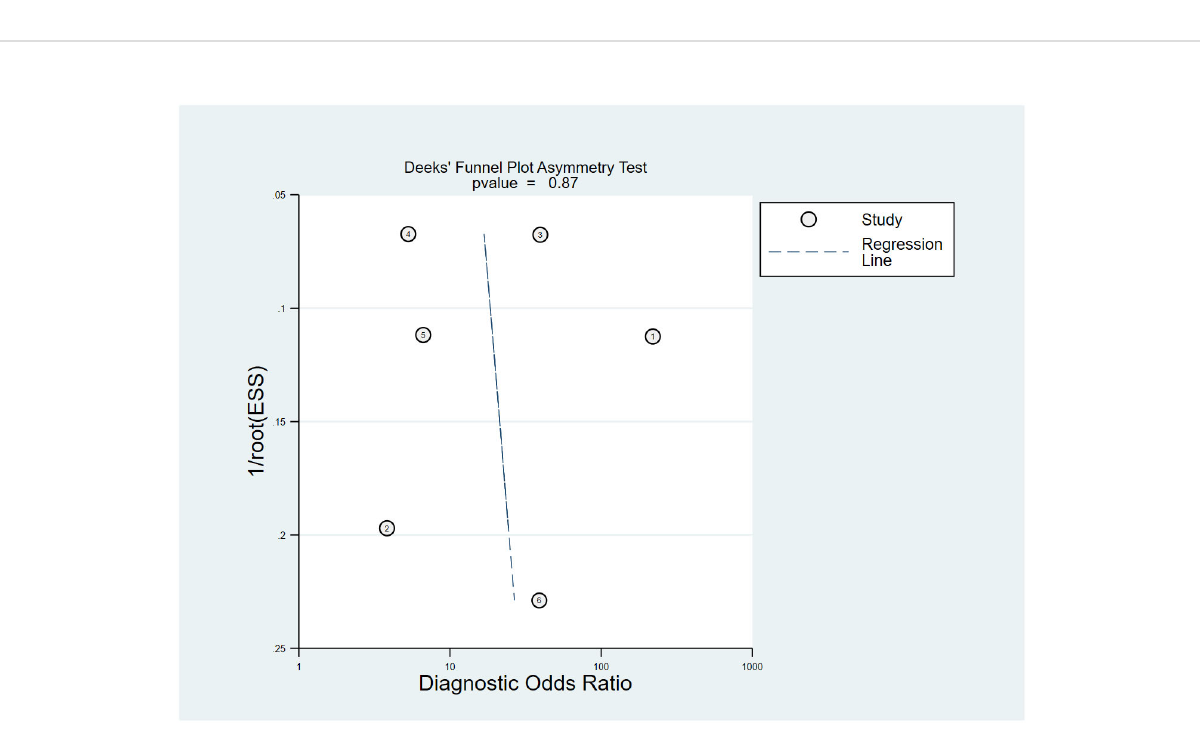
FIGURE 3 Deeks ’ funnel